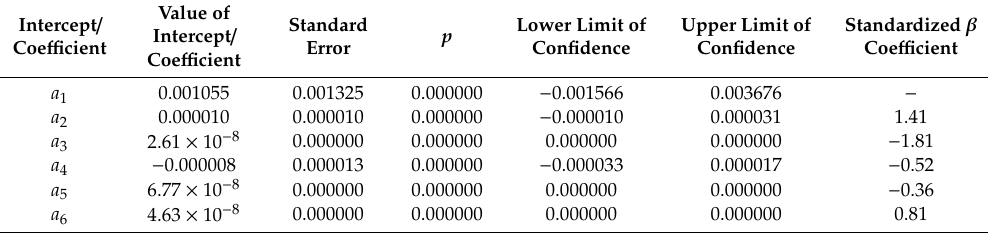
Table 12. Statistical evaluation of S content model of torrefied pruned biomass.